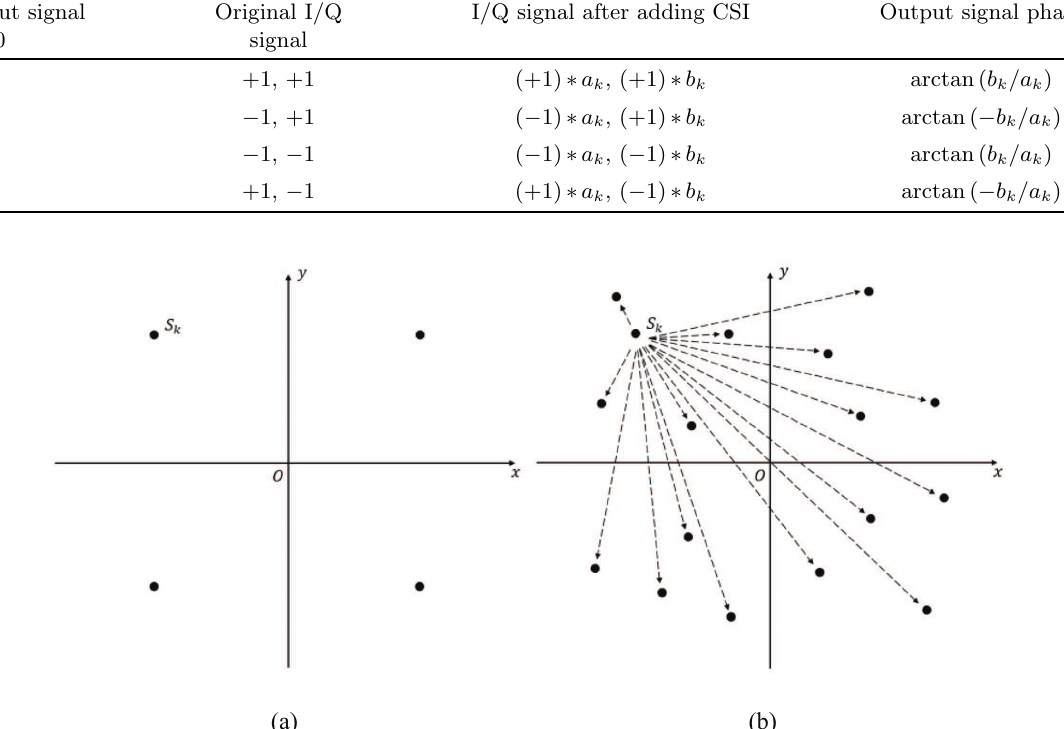
Figure 6. I/Q modulation and CSI-QPSK modulation constellation: (a) I/Q modulation constellation diagram; (b) CSI- QPSK modulation